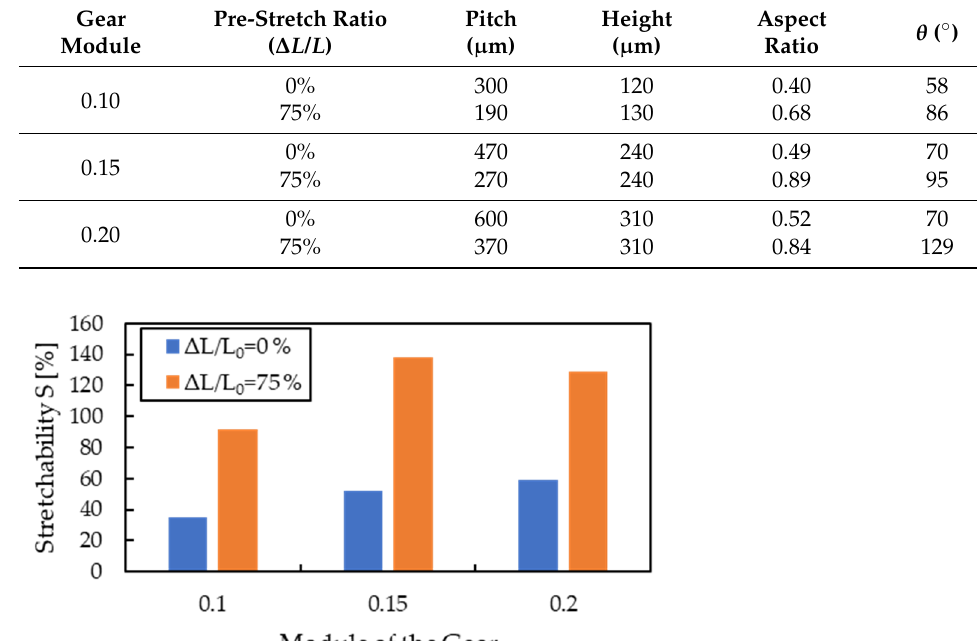
Table 1. The measured value of each wavy structure fabricated by micro-corrugation process and with or without pre-stretch.